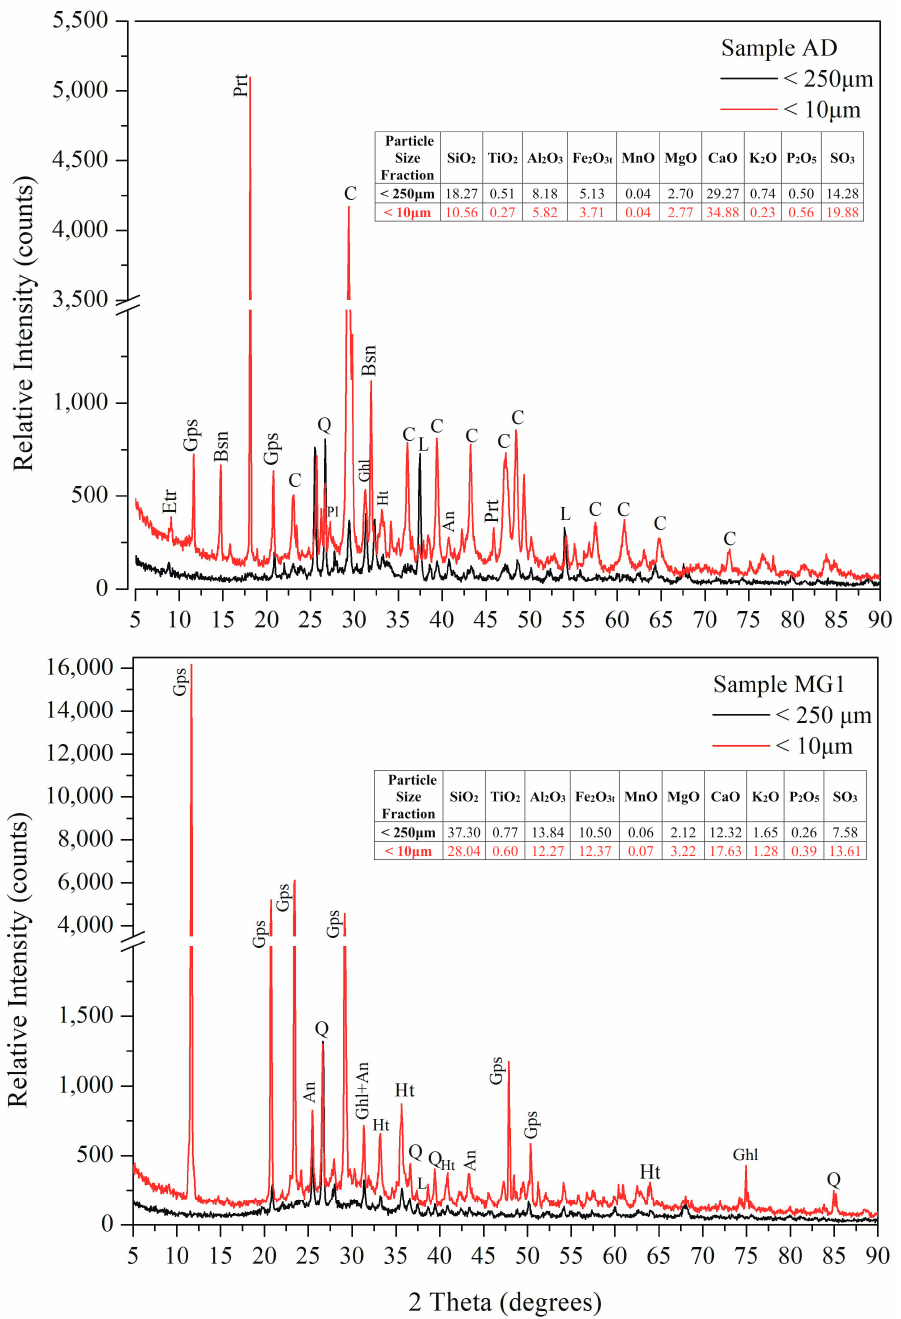
Figure 1. Representative XRD patterns of Ca-rich (Sample AD, top) and Si-rich (Sample MG1, bottom) fly-ash samples of the two different studied size fractions. An: anhydrite, Bsn: bassanite, C: calcite, Etr: ettringite, Ghl: gehlenite, Gps: gypsum, Ht: hematite, L: lime, Prt: portlandite, Pl: plagioclase, Q: quartz. The concentration units of pXRF results are given in the inlets. As reported [41], ingestible LFA fractions (<250 µ m) contained both amorphous and crystalline mineral phases with quartz and a number of Ca-bearing mineral phases dom- inating. Significant differences in the mineralogy of the inhalable size fraction (<10 µ m) of Ca- and Si-rich LFA were revealed. Specifically, quartz content decreased with the decrease in particle size, indicating that quartz tended to aggregate in the coarse fly-ash fractions. Inversely, the calcium mineral content greatly increased with the decrease in particle size, showing a relatively high content of Ca-bearing minerals in finer LFA